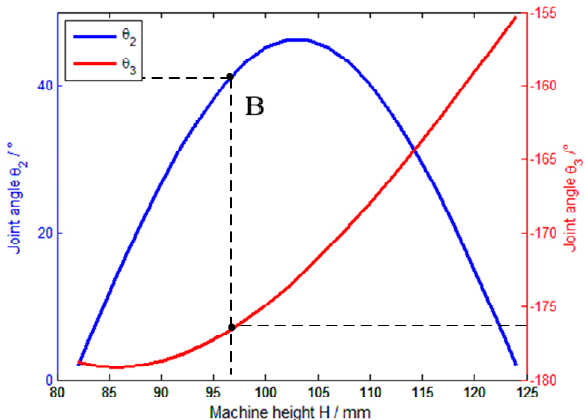
Figure 7. Joint angle of θ 2 and θ 3 when M is minimum under different center of gravity heights.